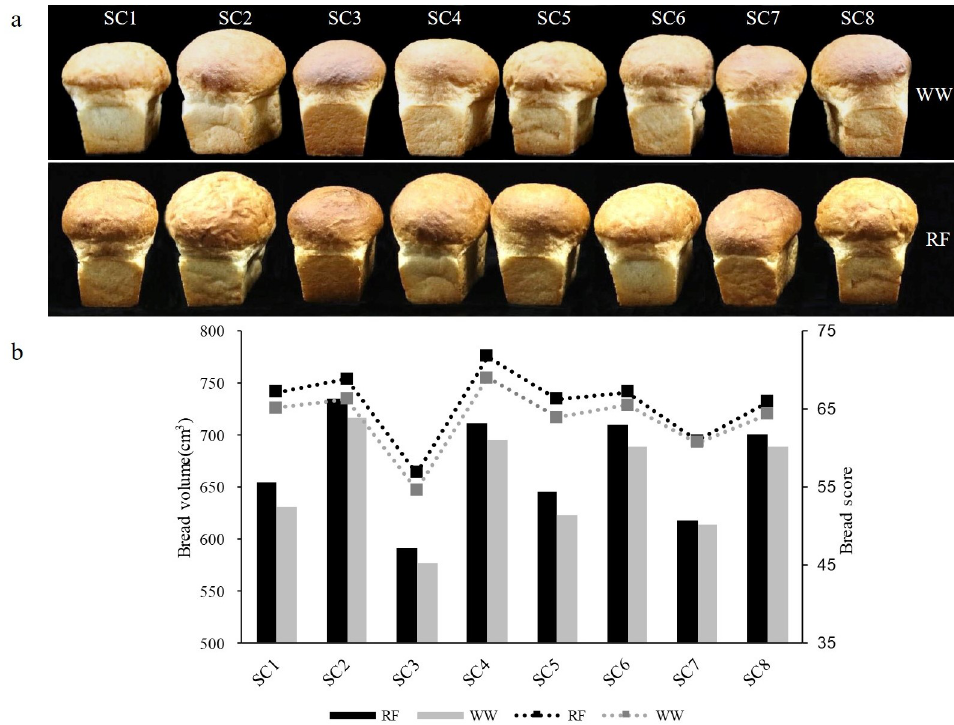
Fig 1. Effects of HMW-GS on bread-making properties under two water regimes. (a) Bread with different subunit combinations under two water regimes, (b) bread volumes and scores of different HMW-GS combinations under two water